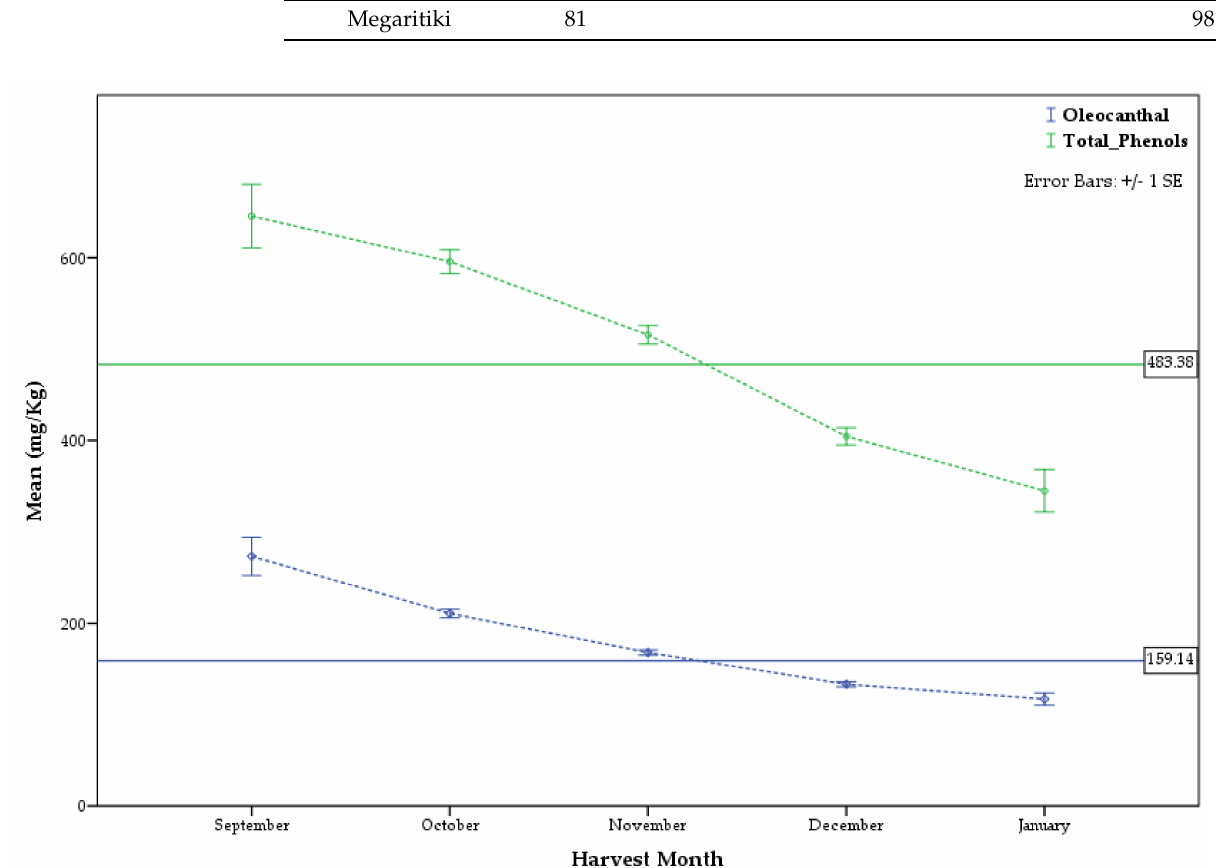
Figure 5. Difference in concentration of oleocanthal and total phenols in relation to harvest